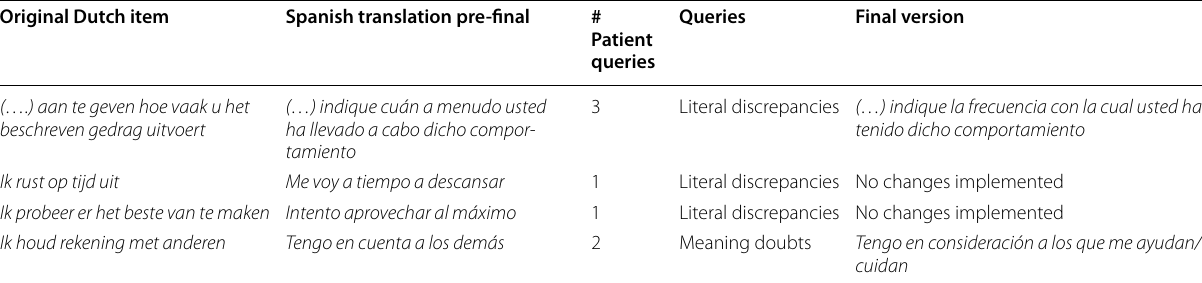
Table 1 Cognitive debriefing queries and final decisions from the expert committee Original Dutch